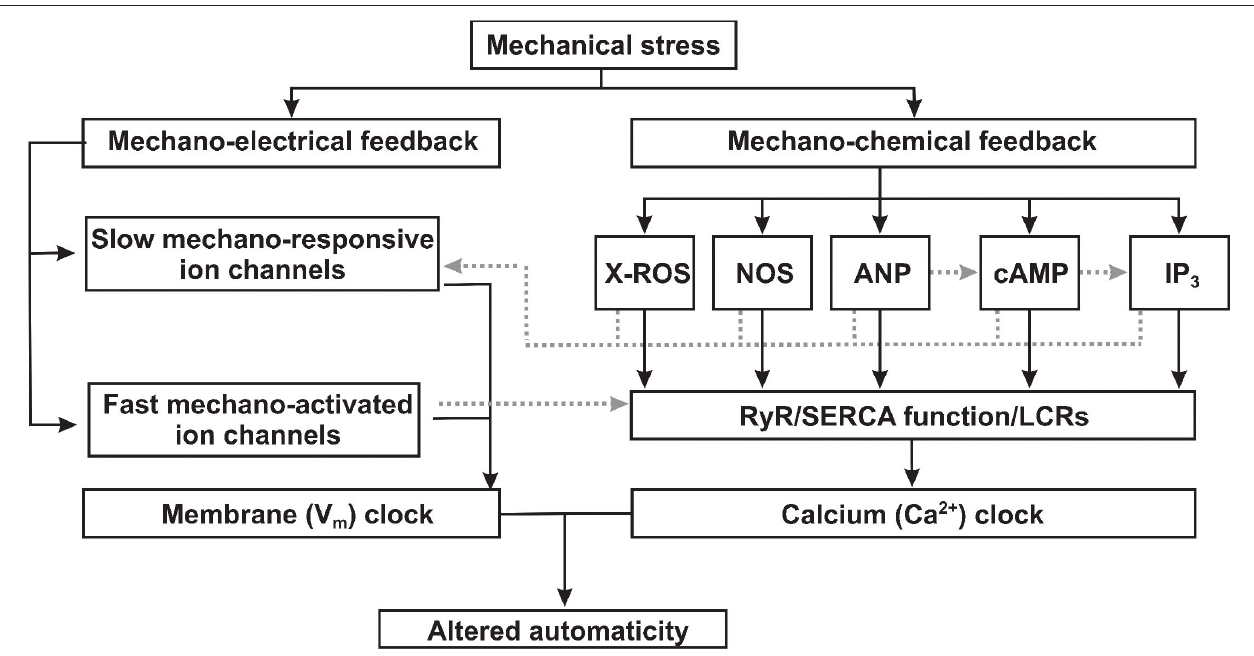
FIGURE 1 | Proposed mechanisms of mechano-electrical and mechano-chemical feedback contributions to sinoatrial node mechanosensitivity. Mechanical stress (1) triggers mechano-electrical signal transduction pathways via both slow mechano-responsive and fast mechano-activated ion channels directly changing the membrane (V m ) clock component of the coupled-clock pacemaker system; and (2) activates mechano-chemical feedback via various signaling factors which alters the function of the calcium (Ca 2 + ) clock component of the coupled-clock pacemaker system. ROS, reactive oxygen species; NOS, nitric oxide synthase; ANP,